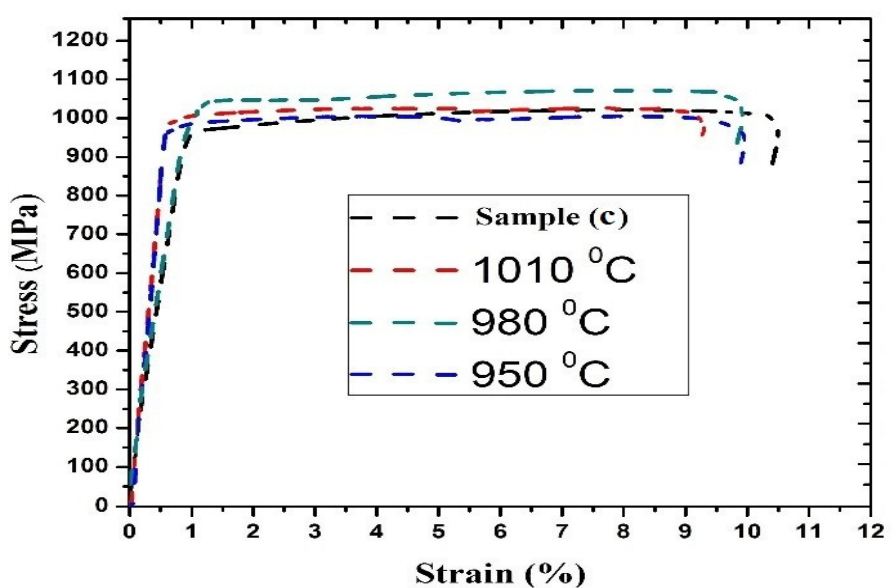
Figure 9. Stress–strain graph for the annealed samples [17].